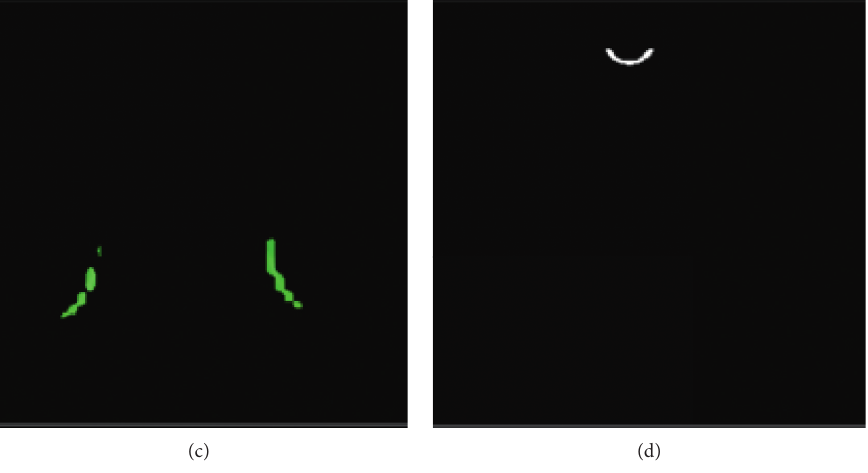
Figure 13: The precise positioning result.